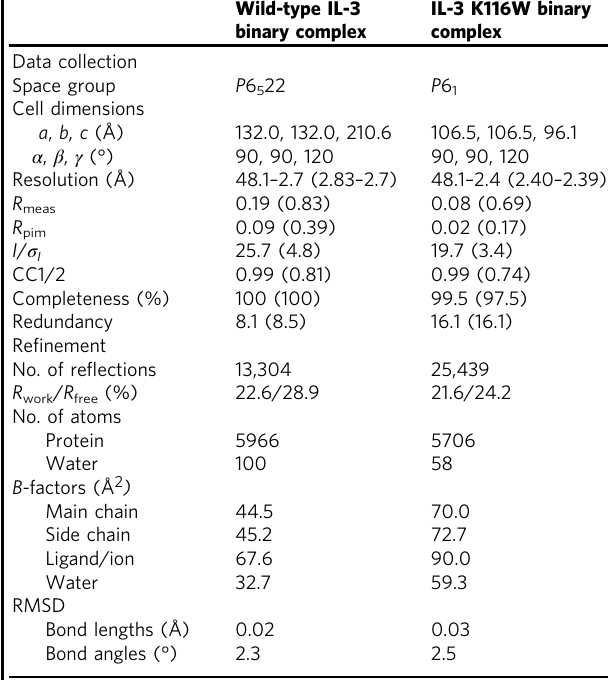
Table 1 Data collection and re fi nement